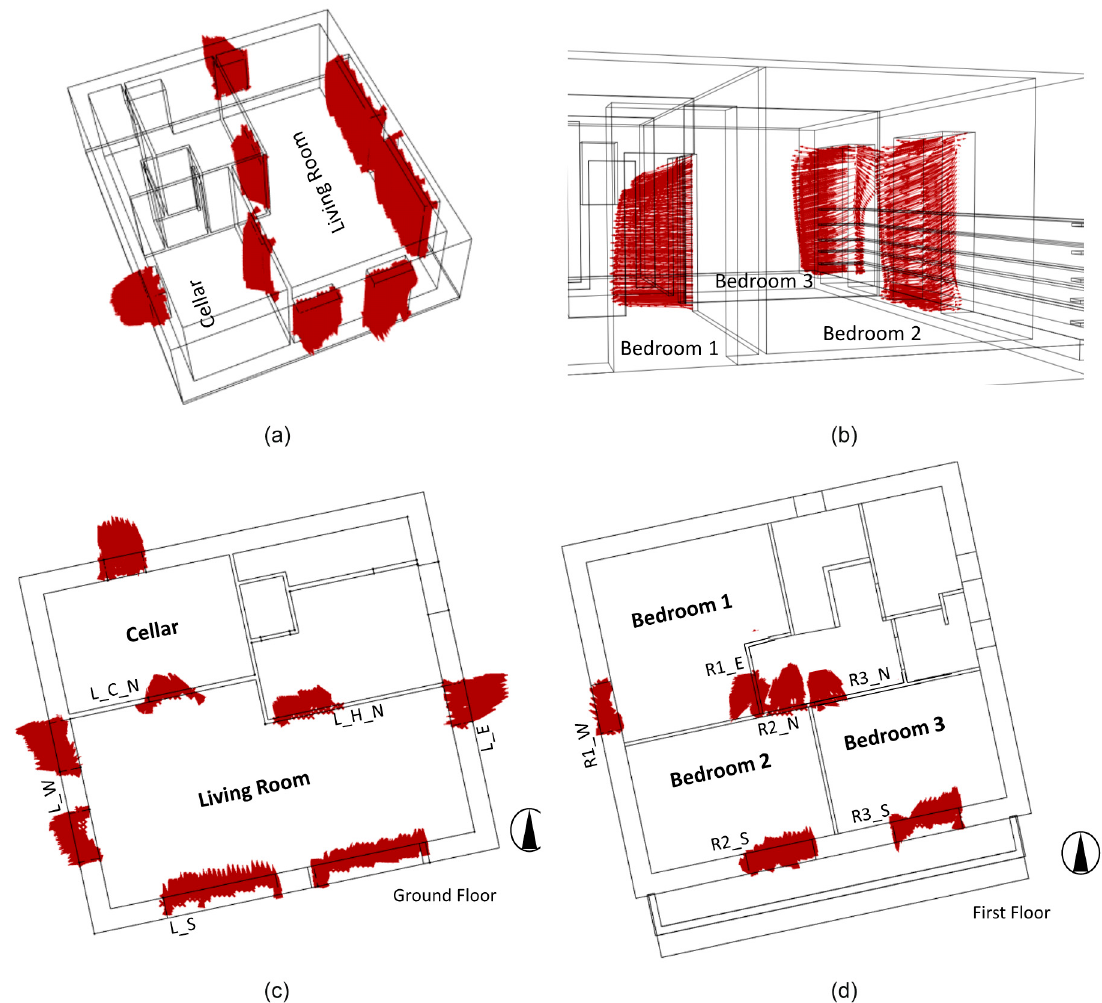
Figure A2. Visualization of the velocity vectors in the openings (integration method), for the south wind direction ( θ = 180 ◦ ). ( a ) 3D Ground floor; ( b ) perspective first floor ( c ), ground floor, and ( d ) first floor.